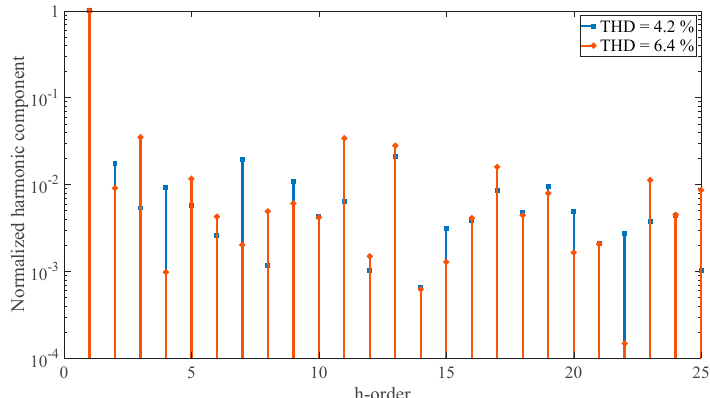
Figure 4. Normalized harmonic components randomly generated for the “Fixed random harmonics” tests ♮ 1 (THD = 4.2%) and test ♮ 2 (THD = 6.4%). THD, Total Harmonic Distortion.